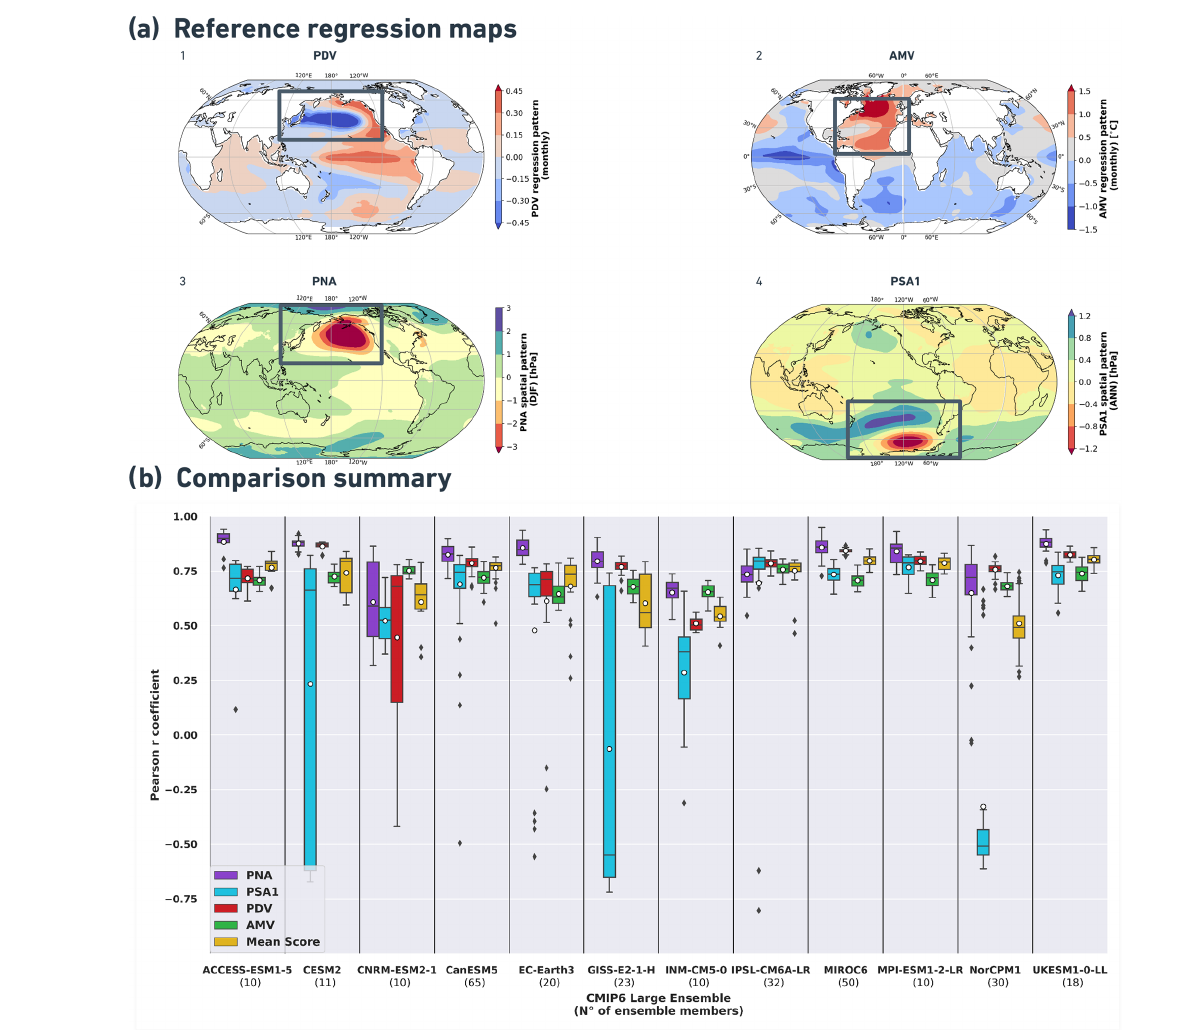
Figure 4. (a) Reference for comparison: SST regression maps showing geographical patterns associated with PDV (1) and AMV (2) and SLP regression maps of geographical patterns associated with PNA (3) and PSA1 (4). The indices are calculated from reanalysis data (ERSSTv5 for AMV and PDV, ERA20C_ERA5 for PNA and PSA1) over the 1900–2014 period using the NCAR CVDP-LE package. Rectangles on the maps approximate the regions over which the indices are defined (see Methods, Sect. 2.1.1). (b) Box plot (or whisker plot) showing the distribution of Pearson r pattern correlation values along the different historical CMIP6 LEs (between parenthesis on the x axis is the number of ensemble members within each model). The bottom of every box (color-coded part) shows the first quartile ( Q 1 or 25th percentile), the top shows the third quartile ( Q 3 or 75th percentile), and the horizontal bar between them denotes the median value ( Q 2 or 50th percentile). The length of the box (from Q 1 to Q 3 ) denotes the interquartile range (IQR), while the bottom and upper whiskers (thin lines extending from boxes) extend to the minimum and maximum values, which are calculated as Q 1 − 1 . 5 × IQR and Q 3 + 1 . 5 × IQR, respectively. The black dots are outliers. PNA correlation values are shown in purple, PSA1 values are shown in cyan, PDV values are shown in red, and AMV values are shown in green. Yellow boxes show the mean score denoting the average of the four r values (after applying a Fischer z transform). White dots denote the mean